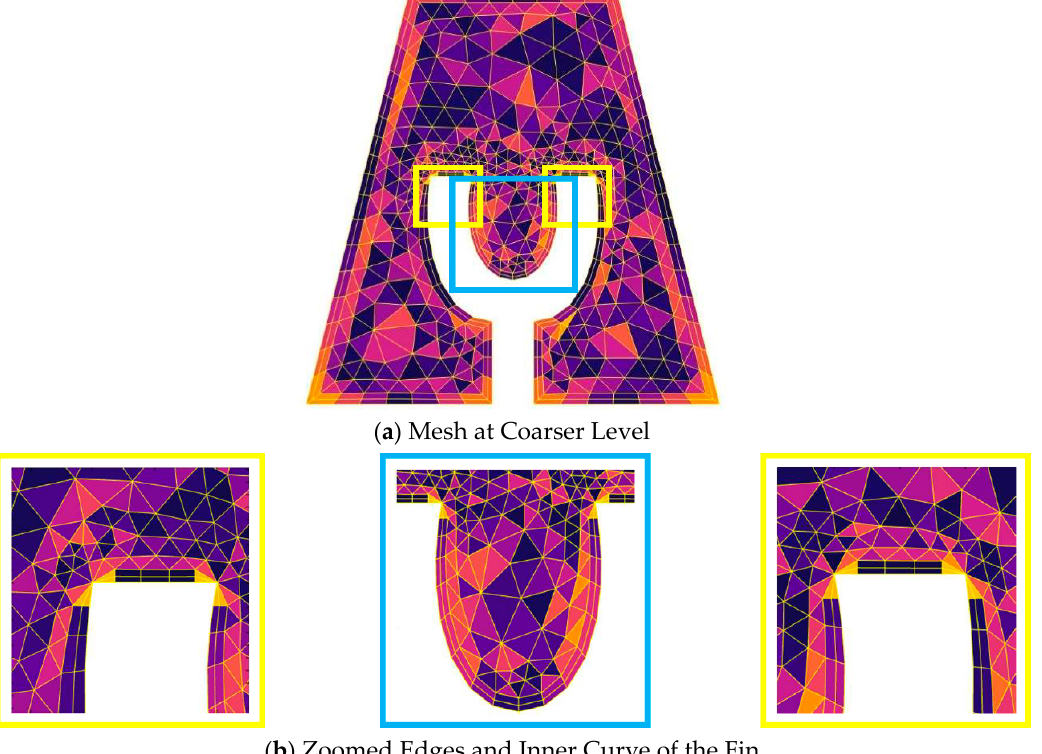
Figure 2. Represents the courser refinement level showing the discretized flow domain and the inclusion of P 2 − P 1 elements of a triangular and quadrilateral nature.